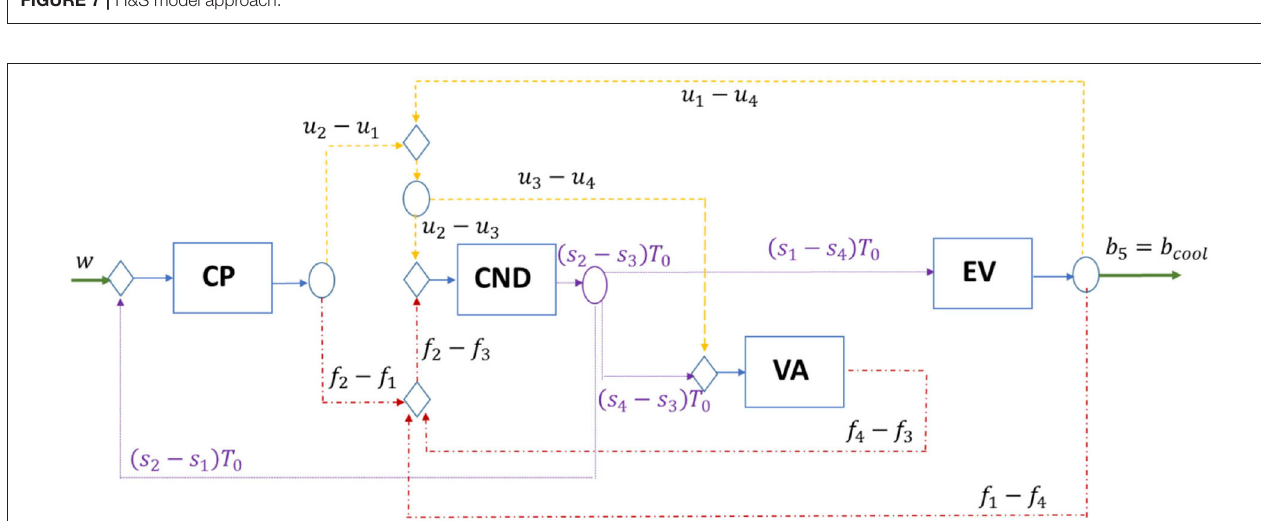
FIGURE 7 | H&S model approach.